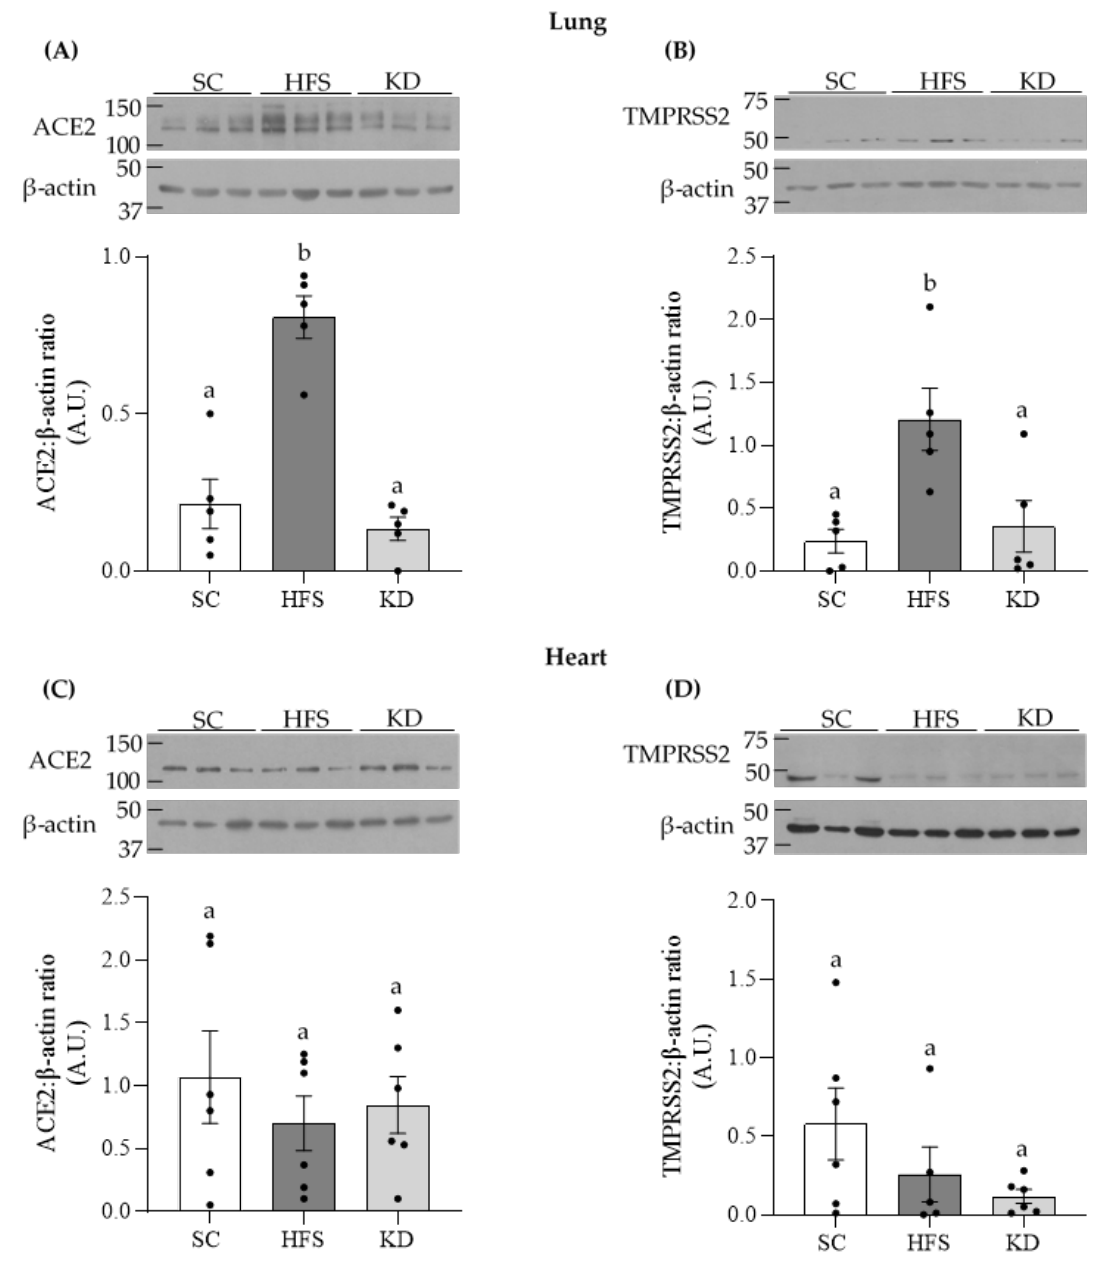
Figure 1. Lung contents of angiotensin converting enzyme 2 (ACE2) ( A ) and transmembrane protease serine 2 (TMPRSS2) ( B ) were significantly elevated by the HFS, but not by the KD. In contrast, diet did not alter the contents of these proteins in heart tissue ( C , D ). Statistical significance is denoted by different letters p < 0.05. Bars represent mean ± SEM. One-way ANOVA, n = 5–6. SC, standard chow; HFS, high-fat sucrose-enriched diet; KD, ketogenic